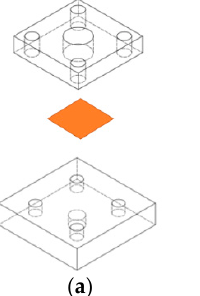
Figure 3. The fixation system of specimens: ( a ) schematic illustration of the fixation system; ( b ) photo of the fixation system.